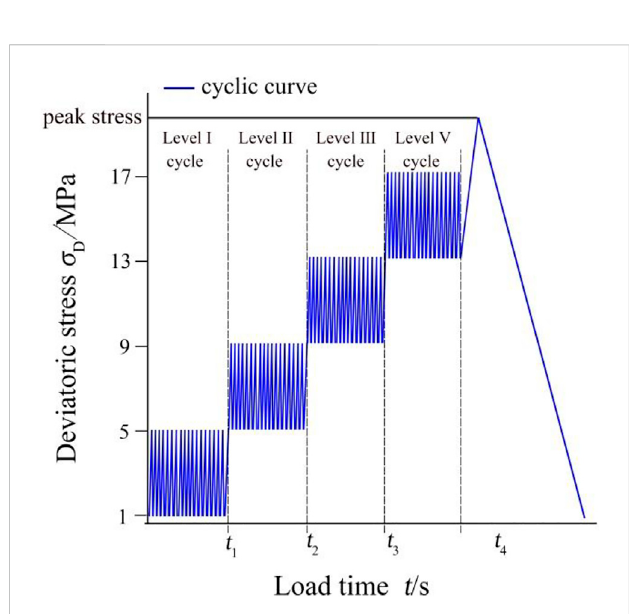
FIGURE 2 Variable stress lower limit cyclic loading and unloading